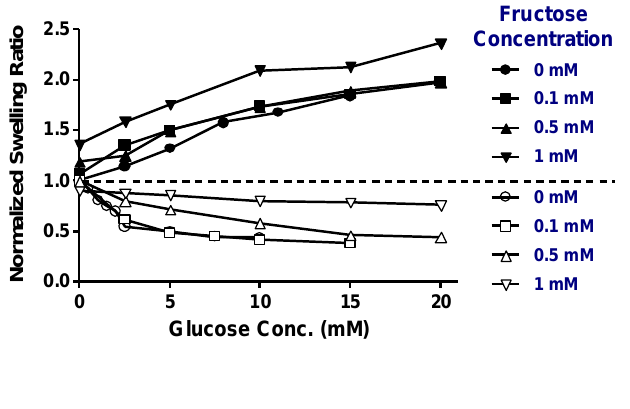
Figure 7. Effect of added fructose on glucose induced swelling (MPBA- co -AAm hydrogels: solid symbols) and shrinking (DMP- co -MPBA- co -AAm hydrogels: unfilled symbols) at pH